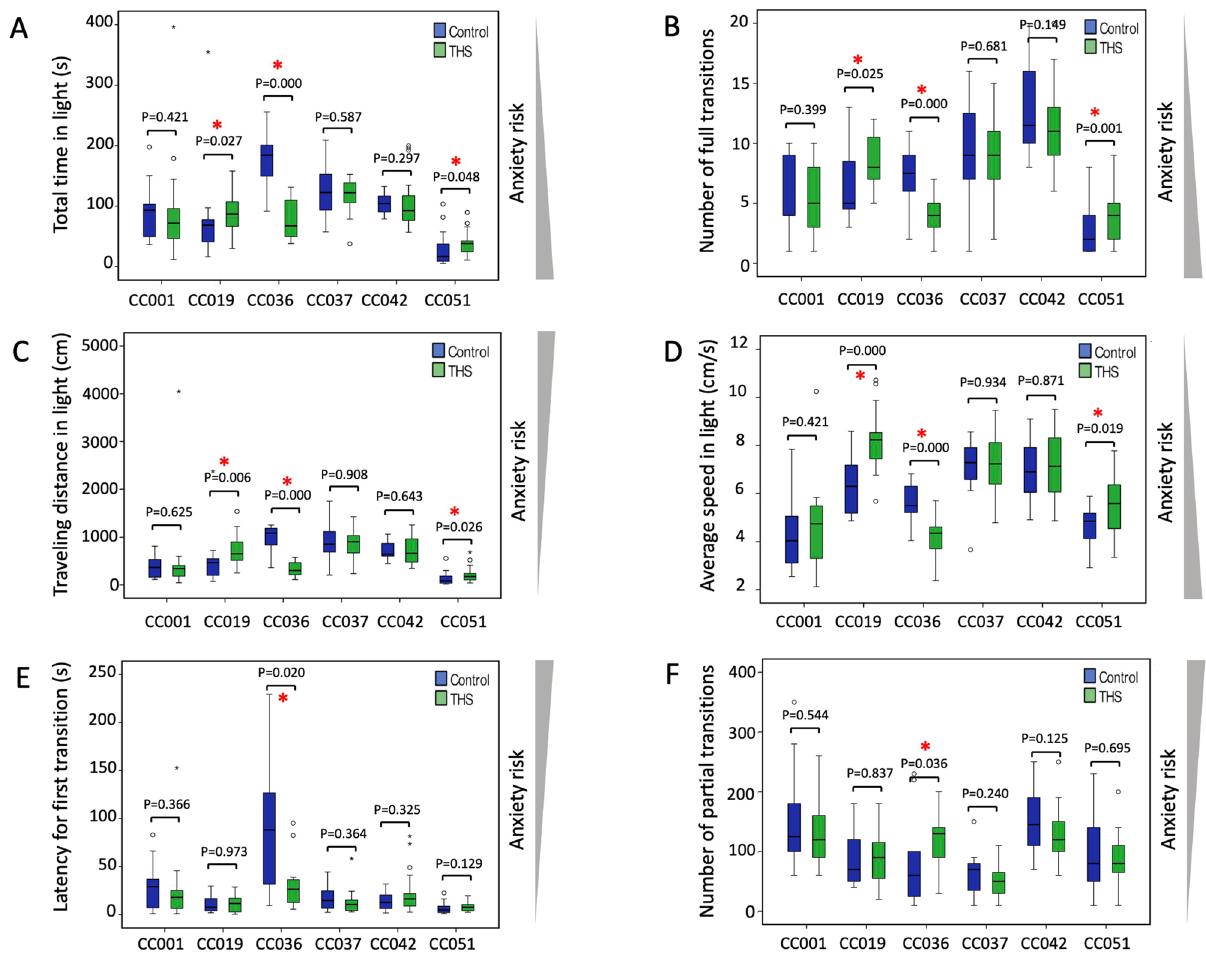
Figure 2. THS exposure effects on anxiety-related phenotypes in six CC strains. The six phenotypes positively or negatively associated with anxiety were measured using the light–dark box. ( A ) Total time in light (s), ( B ) number of full transitions, ( C ) traveling distance in light (cm), ( D ) average speed in light (cm/s), ( E ) latency to first transition (s), ( F ) number of partial transitions. Control mice are shown in blue and THS exposed mice in green. Bars indicate the 1st and 3rd quartiles and the thick horizontal line indicates the median. Error bars indicate minimum and maximum values excluding outliers. P values were obtained by Mann–Whitney test. A red asterisk indicates a P value < 0.05. The triangle bars on the right side of the plots indicate the direction of anxiety risk. See Table 1 and Supplementary Figure S1 for more